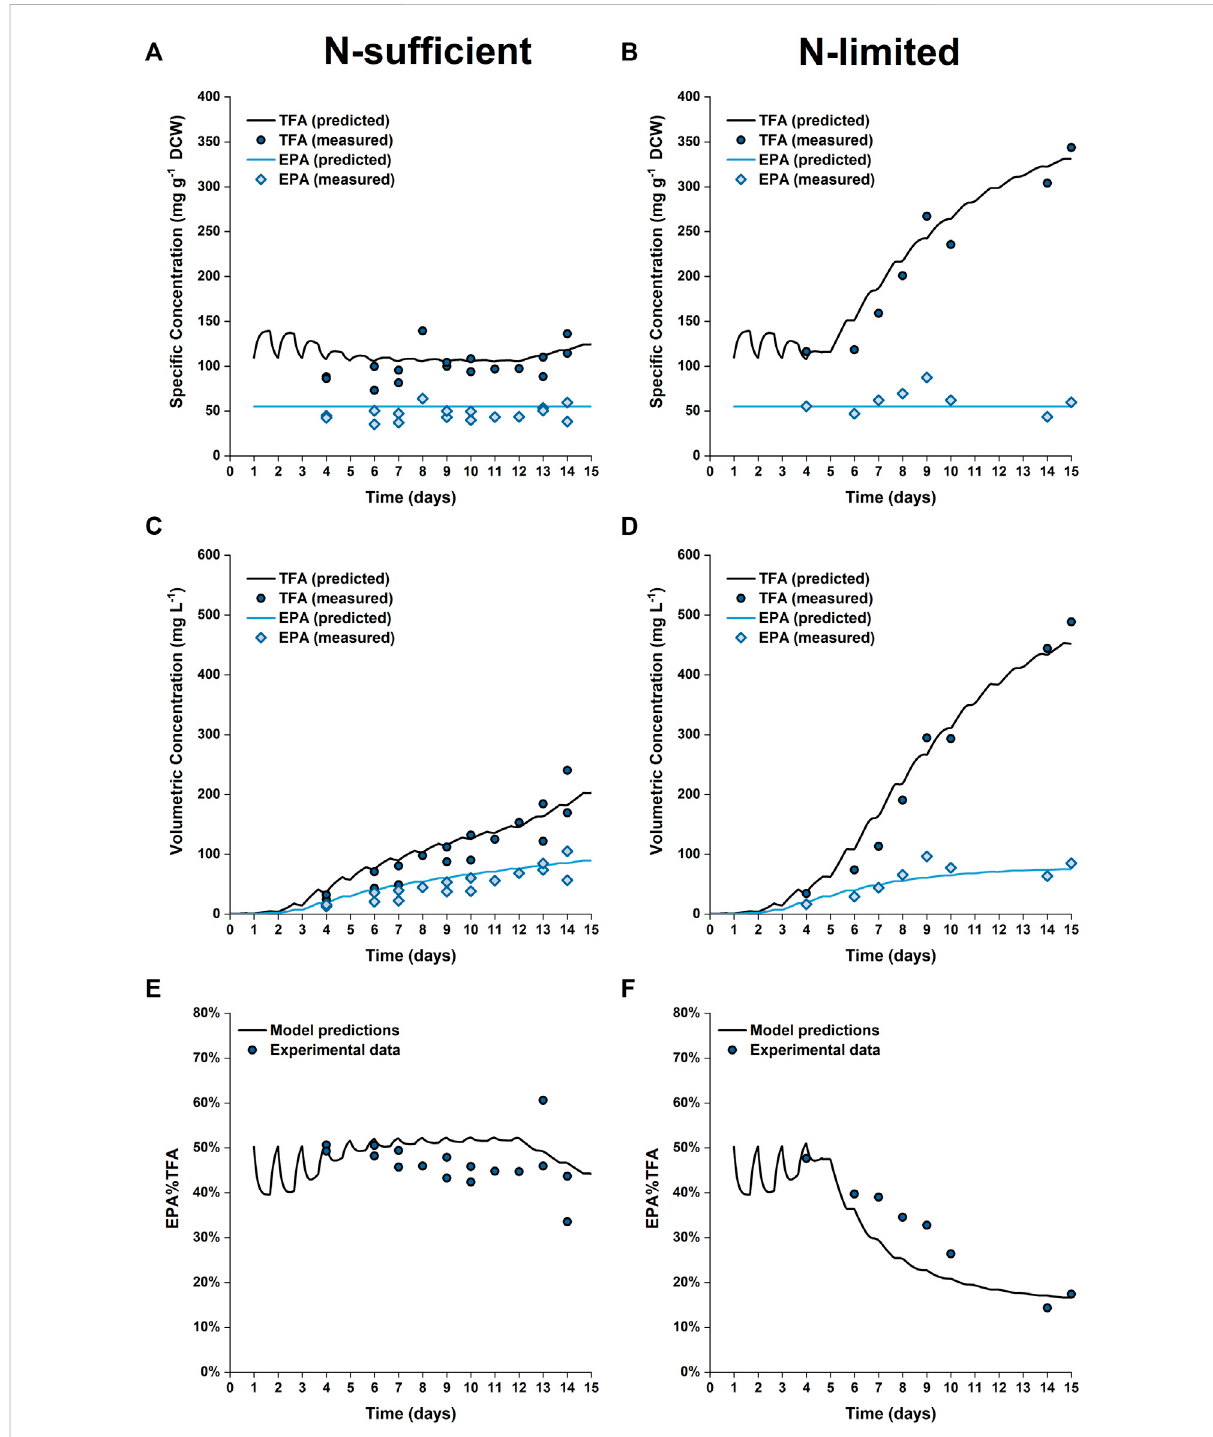
FIGURE 8 Comparison betweenexperimentallymeasuredandmodelpredictedspeci fi cconcentrationsoftotalfattyacids(TFA)andEPAinbiomass (A,B) , volumetric concentrations of TFA and EPA (C,D) and EPA fraction in TFA (E,F) of P. tricornutum grown under N-suf fi cient (A,C,E) and N-limited (B,D,F) conditions. Batch cultures were grown in 50 L bubble column PBRs, with two biologically independent replicates for N-suf fi cient conditions and one for N-limited